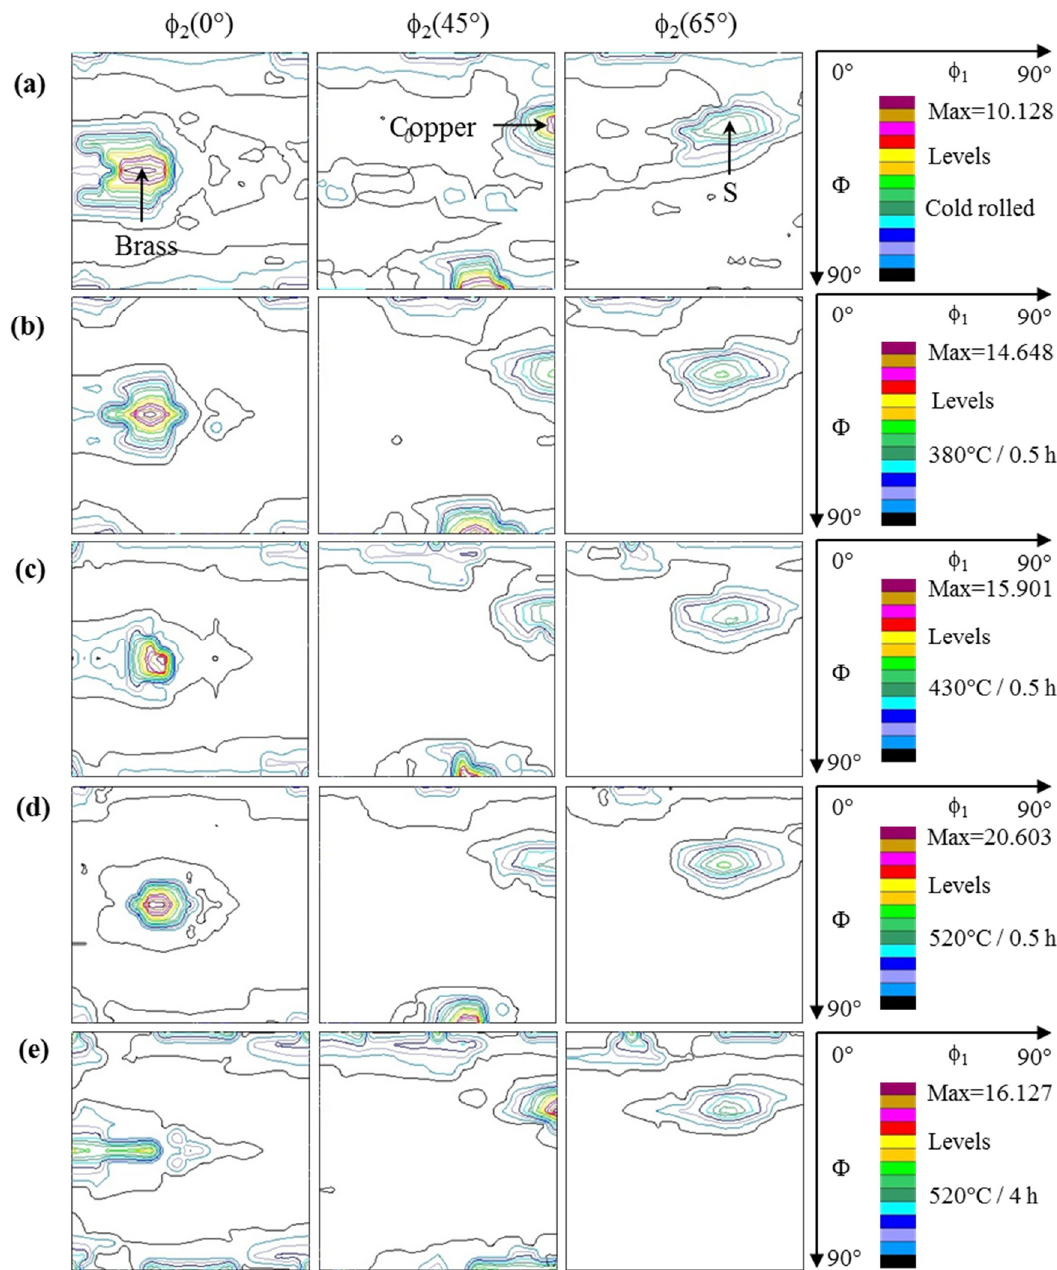
Figure 2. Orientation distribution function (ODFs) representative sections of cold rolled Ce-containing alloy under different annealing temperatures and times: ( a ) cold rolled; ( b ) 380 °C/0.5 h; ( c ) 430 °C/0.5 h; ( d ) 520 °C/0.5 h; ( e ) 520 °C/4 h.